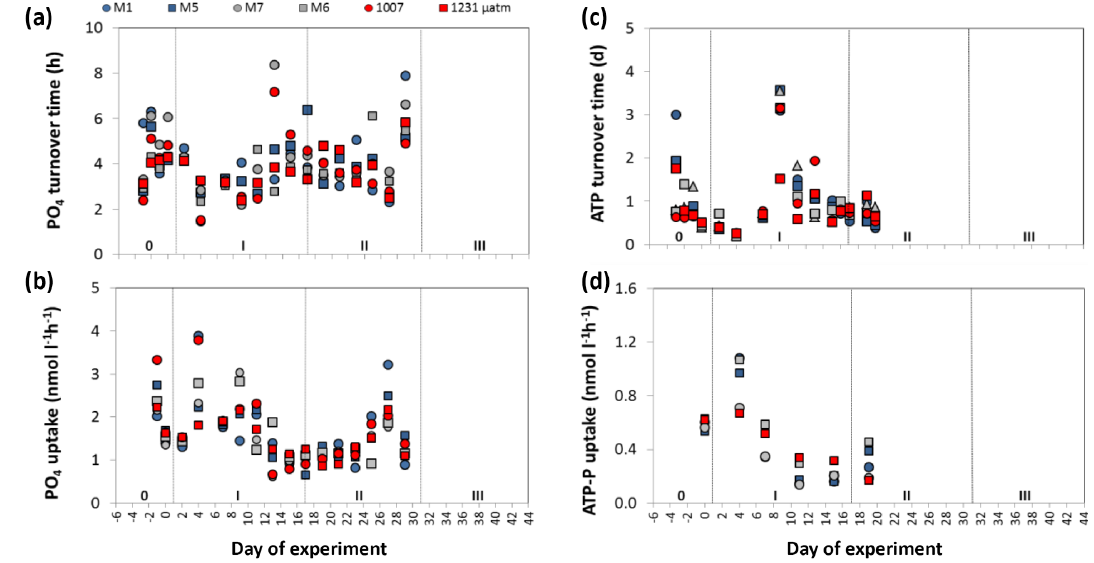
Figure 9. Turnover times of PO 4 (a) and ATP (c) in the mesocosms as well as the respective uptake rates (b, d) .